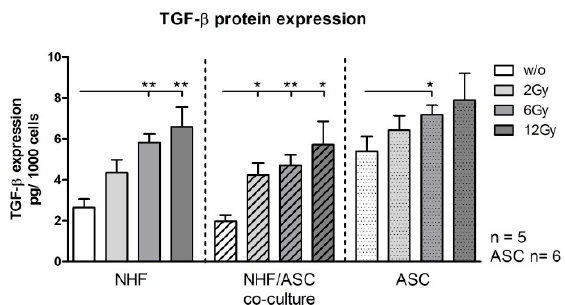
Figure 4. Protein expression of TGF- β in cell culture supernatants of NHF, ASC and co-cultured NHF/ASC 48 h after irradiation with 2–12 Gy compared to unirradiated controls as determined by ELISA. Error bars represent standard error of the mean. NHF, co-cultures n = 5; ASC n = 6. * p < 0.05, ** p < 0.01.